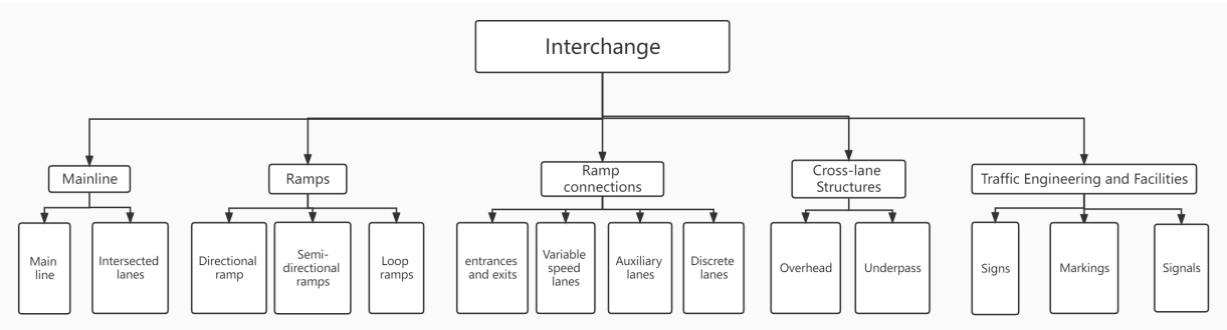
Figure 2. Classification of interchange components.